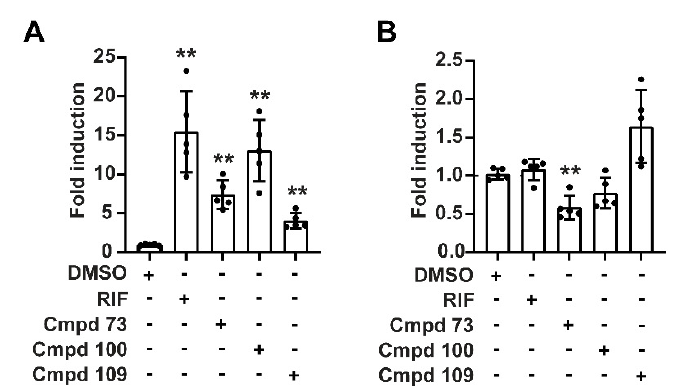
Figure 5. PXR binding of phenylaminobenzosuberones is indicated by cellular PXR LBD assembly assay and inhibition of LBP-filled PXR mutant ( A ) Novel compounds induce PXR LBD assembly. HepG2 cells were transiently transfected with GL4-G5 reporter, GAL4-DBD/PXR LBD(132–188), and VP16-AD/PXR LBD(189–434) fusion protein expression plasmids and treated with 0.1% DMSO, 10 µM rifampicin, or 10 µM test compounds for 24 h. Data are expressed as mean ± SD fold induction with respect to DMSO-treated cells from five independent experiments and individual experiments illustrated with dots. ( B ) Effects of novel compounds on LBP-filled PXR mutant. HepG2 cells were transiently transfected with CYP3A4 reporter and expression plasmid encoding PXR(S208W/S247W/C284W) and treated as described above. Data are shown as mean ± SD fold induction, with respect to treatment with DMSO only, from five independent experiments. Statistically significant differences are illustrated with asterisks. ** p ˂ 0.01, compared to respective treatments with DMSO analyzed by repeated measures one-way ANOVA with Dunnett’s multiple comparisons test.